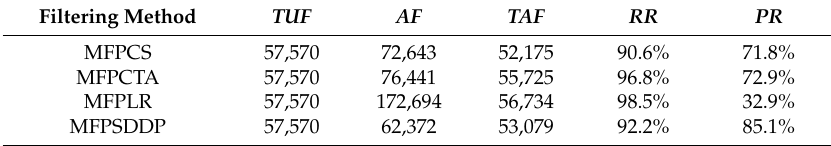
Table 3. The RRs and PRs of four methods when the number of webpages filtered is nearly